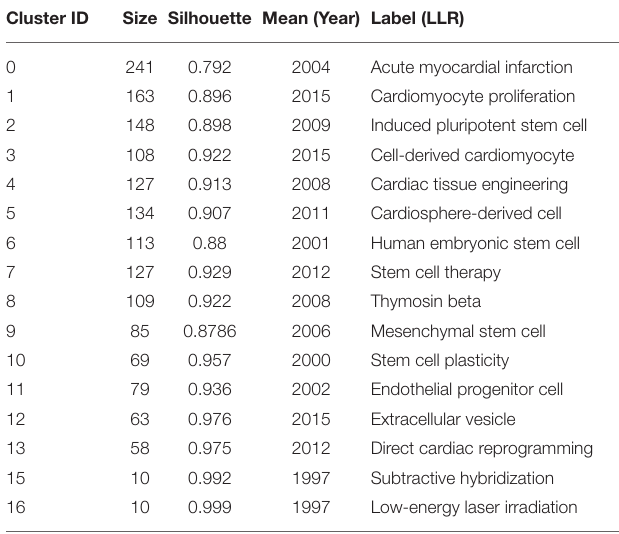
TABLE 5 | Details of clusters. Cluster